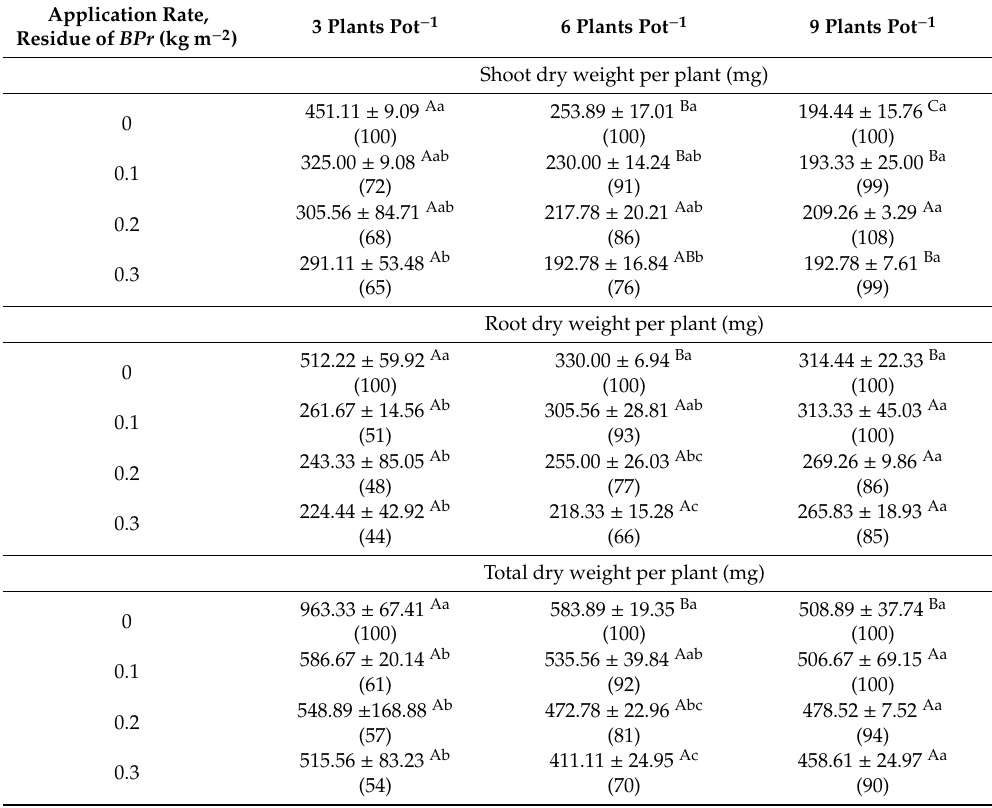
Table 1. Shoot, root and total dry weight per plant of C. rotundus (CR ) growing in pot treated with the